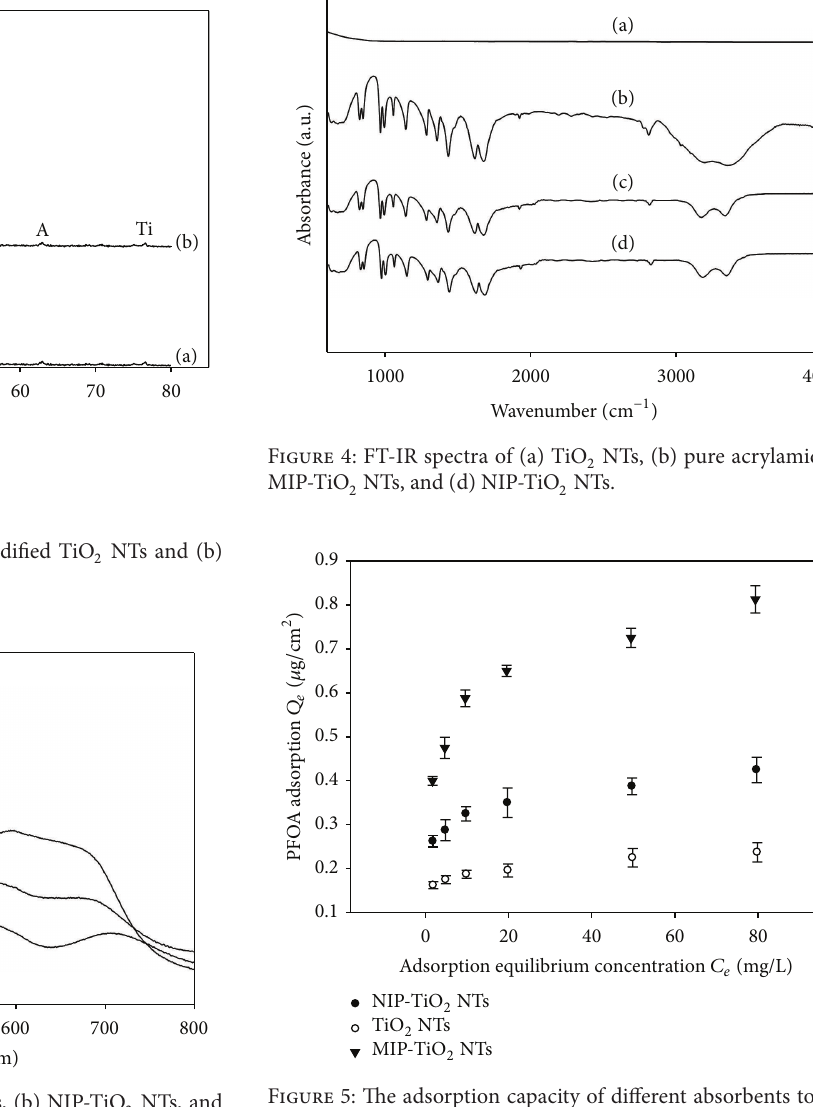
Figure 3: UV-vis spectra of (a) TiO 2 NTs, (b) NIP-TiO 2 NTs, and (c) MIP-TiO 2 NTs.